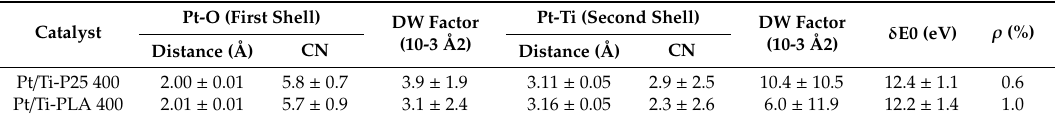
Figure 5. Raman spectra in range 100–200 cm − 1 for (a) Pt/Ti-PLA and (b) Pt/Ti-P25 catalysts, calcined at 400 ° С (1), 600 ° С (2) and 800 ° С